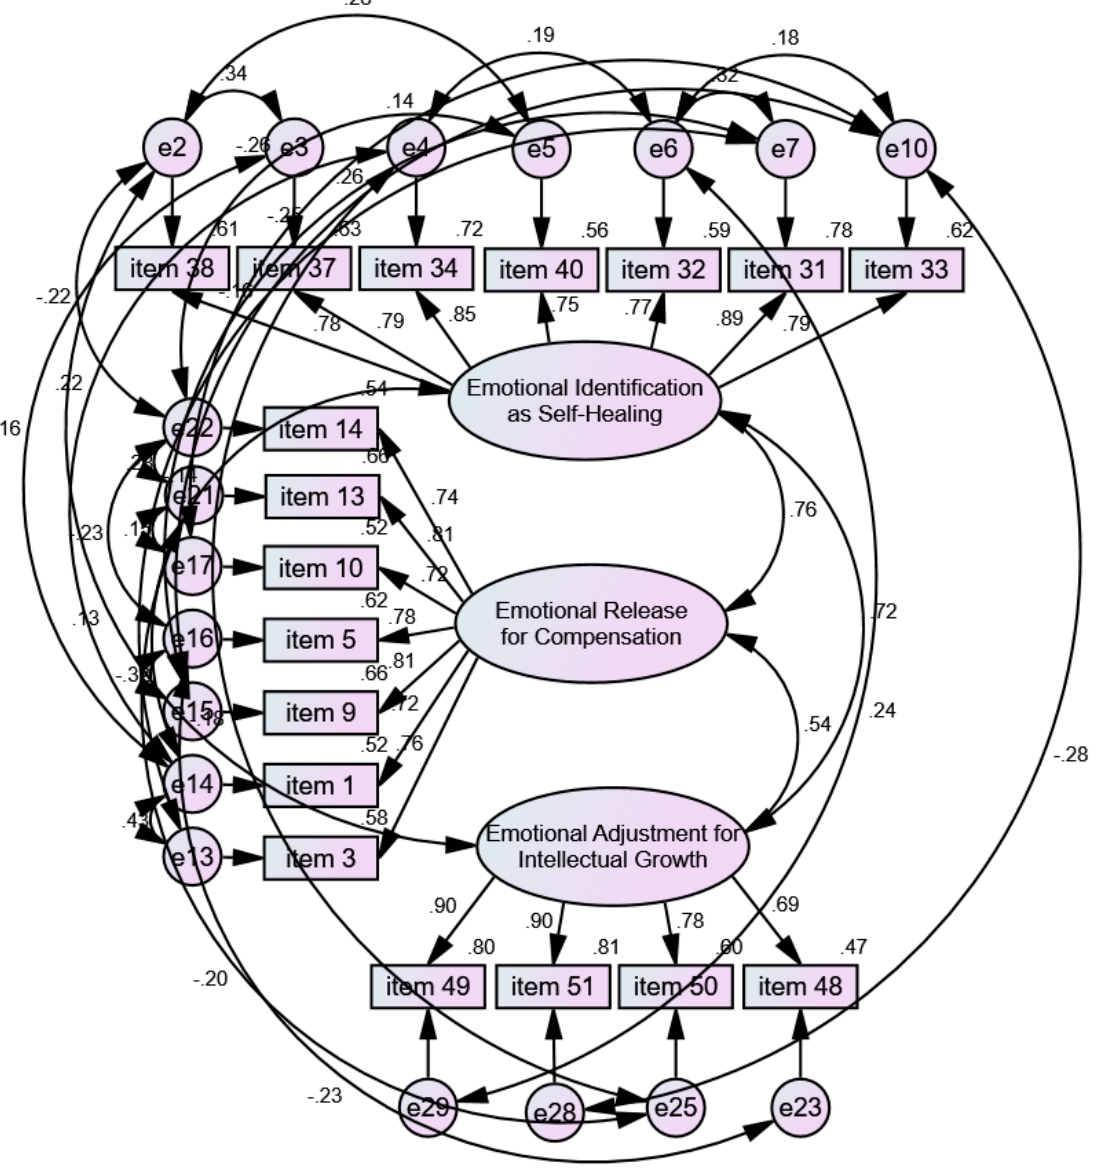
Figure 2. Reduced version (18 items) of the ECS-IN scale.